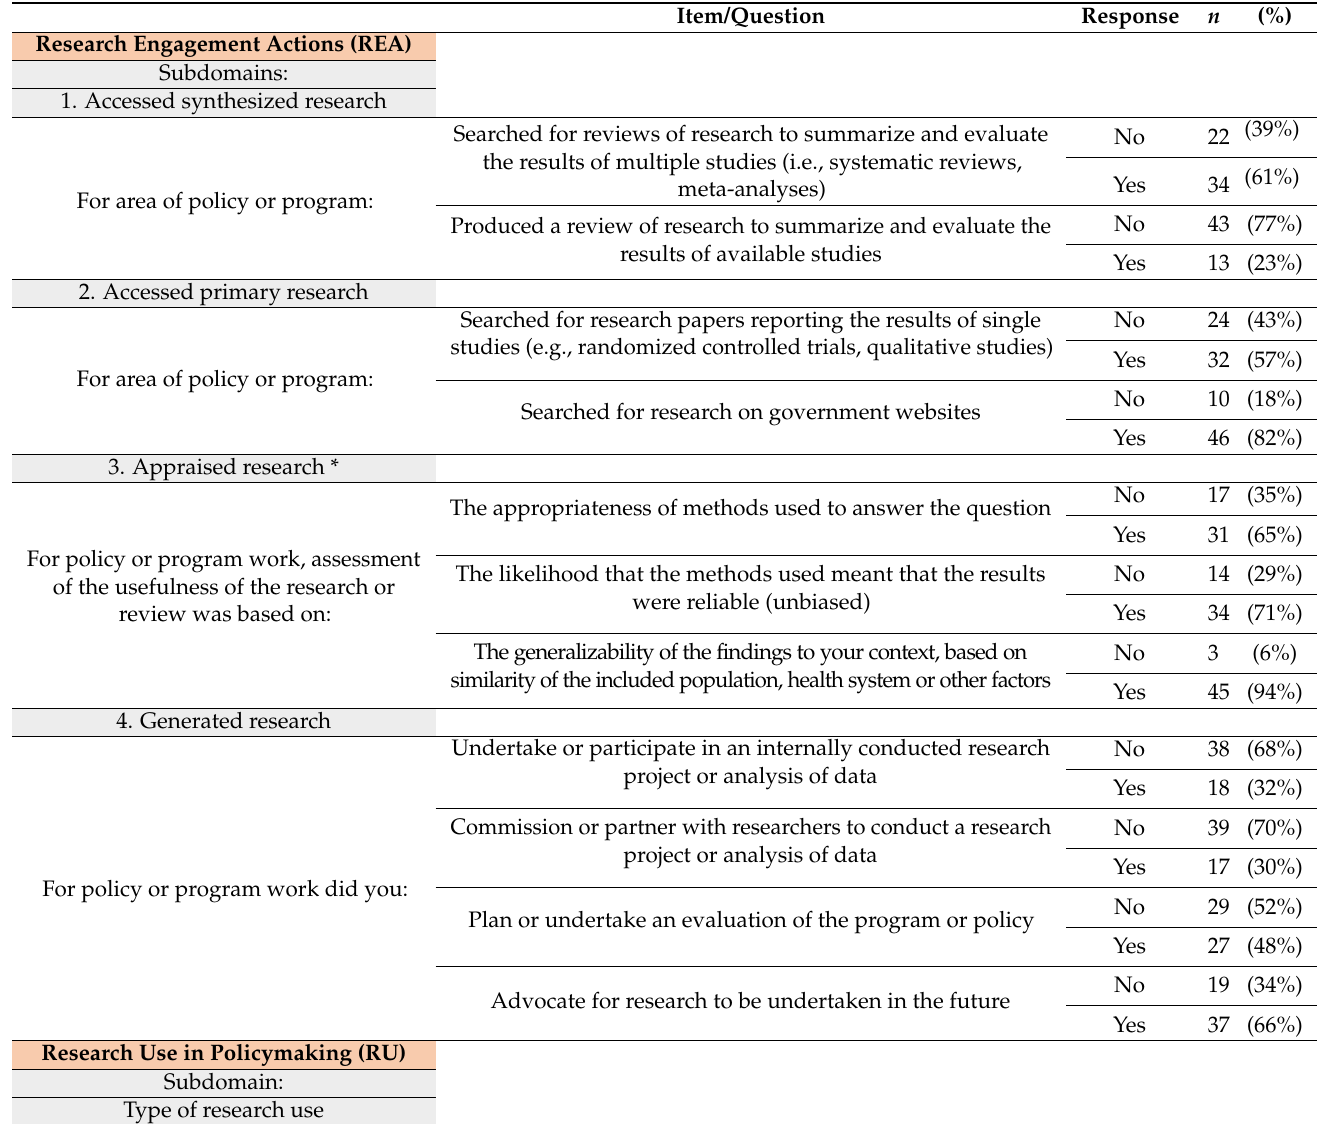
Table 3. REA and RU in frequencies and